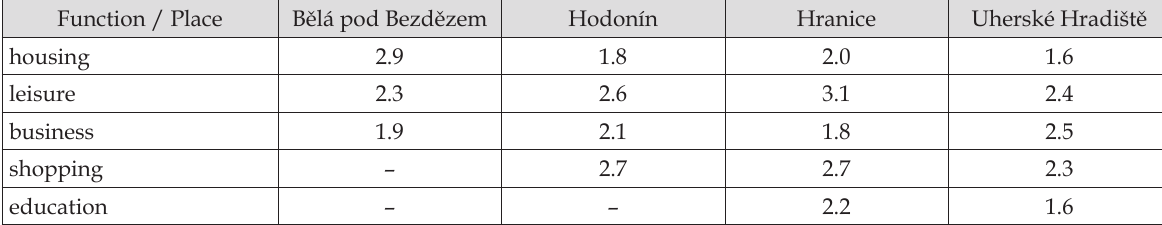
Fig. 7. Partial results of the research on positively rated func - tions of post-military areas in the intra-urban environment Source: authors’ own research Table 3. Summary of the resulting average values for functional uses in terms of their attractiveness to local